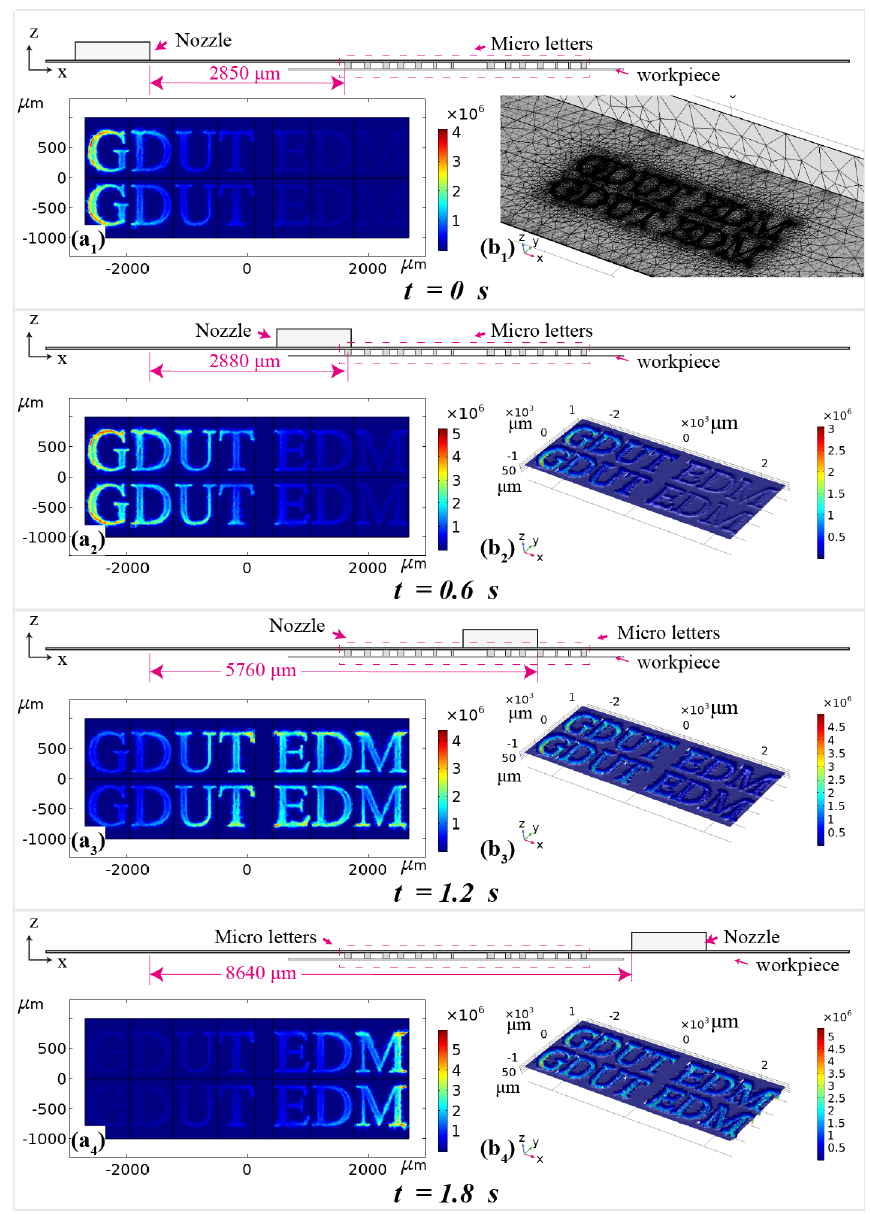
Figure 4. ( a 1 – a 4 ) Current density distribution (surface: A /m 2 ), ( b 1 ) Mesh at t = 0 s, ( b 2 – b 4 ) Geometry shape depth (surface: 10 − 3